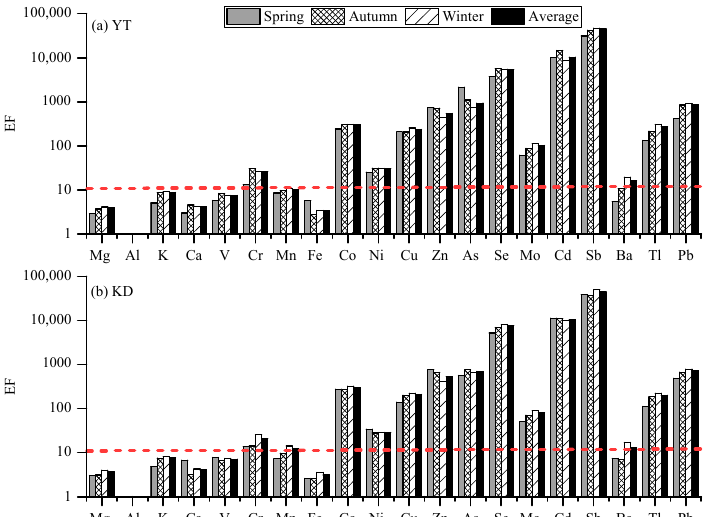
Figure 6. Enrichment factors (EF) values of the detected elements in the PM 2.5 at the two sampling sites during the sampling periods (( a ) YT, ( b )